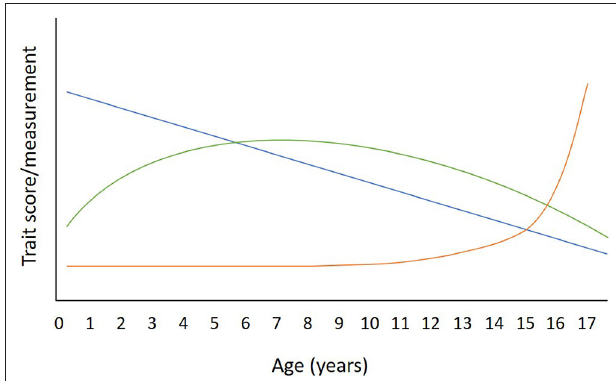
FIGURE 1 | Illustrative example of three different types of relationships that behavioral traits could have with age in the dog. A linear relationship is illustrated in blue. An example of a trait that has a linear relationship with age would be activity/excitability, which peaks in puppyhood and declines steadily throughout the lifespan [e.g., ( 6)]. The Green arc illustrates a quadratic relationship, an example of which is attentiveness, which peaks in early adulthood and declines steadily thereafter [e.g., ( 7)]. The Orange line illustrates a trait that remains relatively stable until late life, when a steep change may be seen. An example of this trajectory is seen with the signs of canine cognitive dysfunction, which rises steadily from age 10 years, then rapidly after the age of 15 years